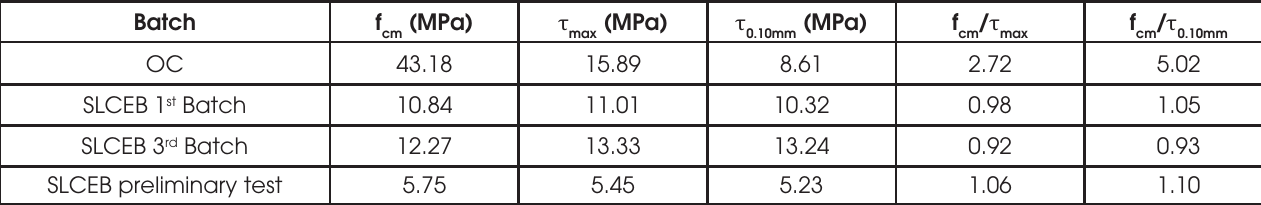
Comparison of average strength to compression (f